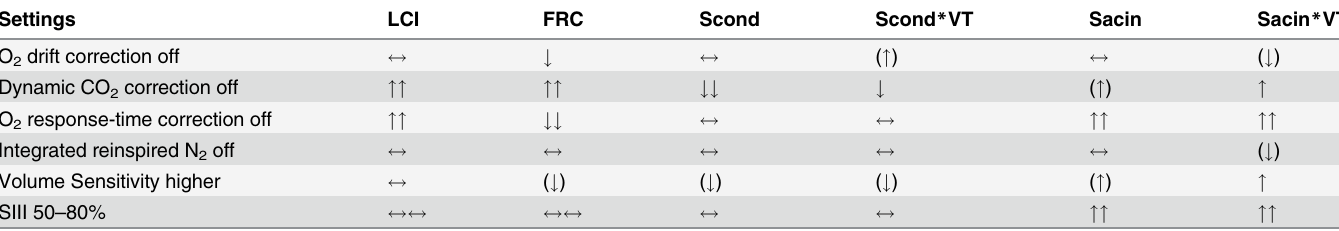
Table 6. Change of N 2 MBW results after reanalysis with different signal processing and detection limits.